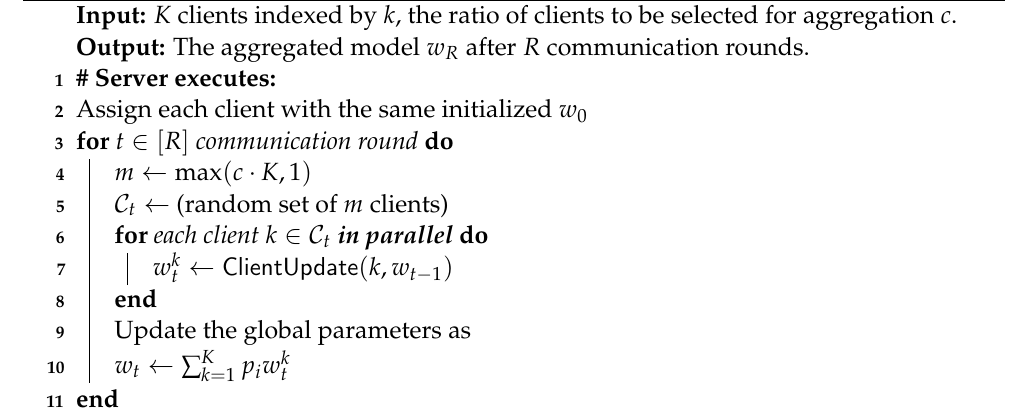
Algorithm 2: ClientUpdate ( k , w )